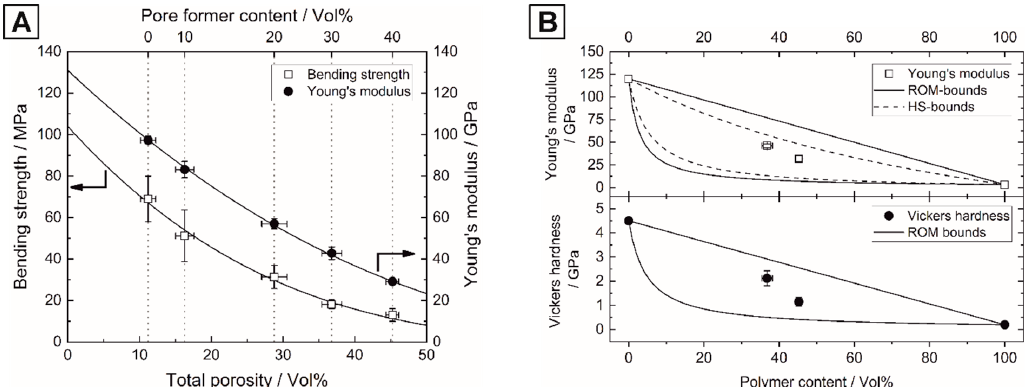
Figure 4. Mechanical properties of the porous HAp ceramics and HAp/urethane dimethacrylate (UDMA) composites: Young’s modulus and flexural strength of the porous HAp ceramics in dependence of the total porosity ( A ) and Young’s modulus and Vickers hardness of the HAp/UDMA composites in dependence of the UDMA-polymer content ( B ).